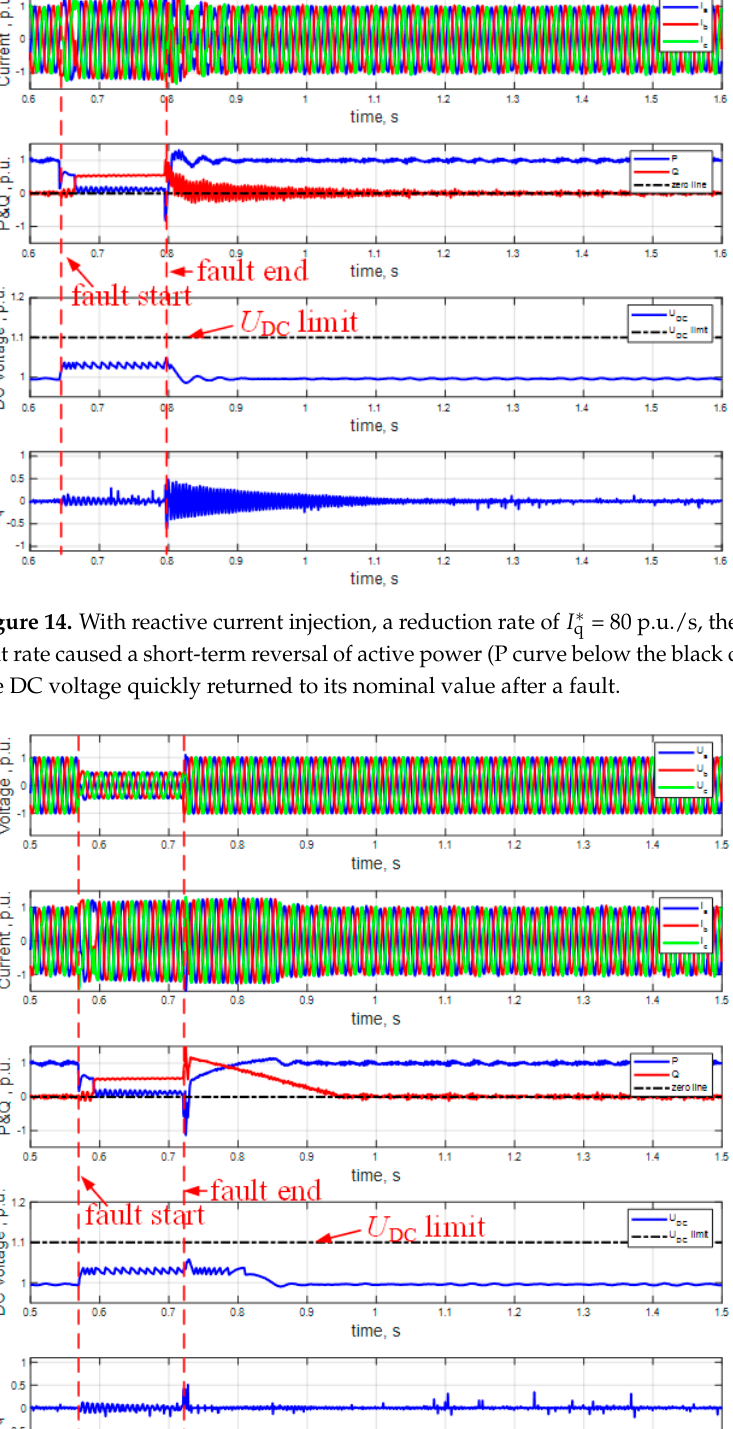
Figure 15. With reactive current injection, variable PLL parameters, a reduction rate of I ∗ q = 5